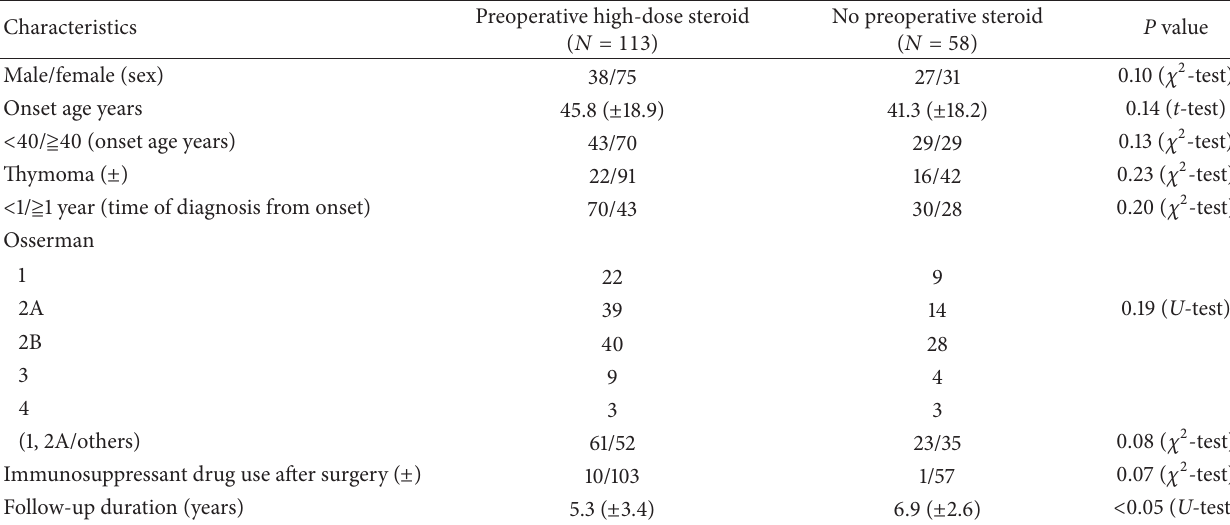
Table 1: Patients